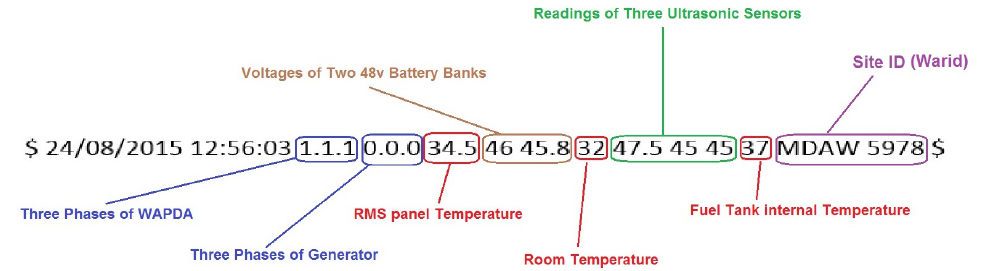
Figure 5. Remote management